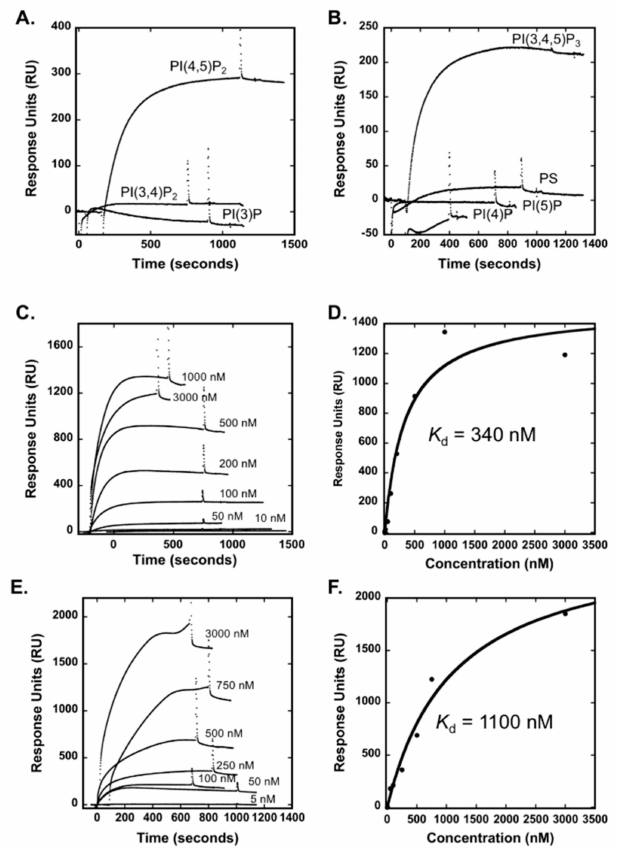
Figure 2. Surface plasmon resonance (SPR) indicates the Smurf1 C2 domain binds to